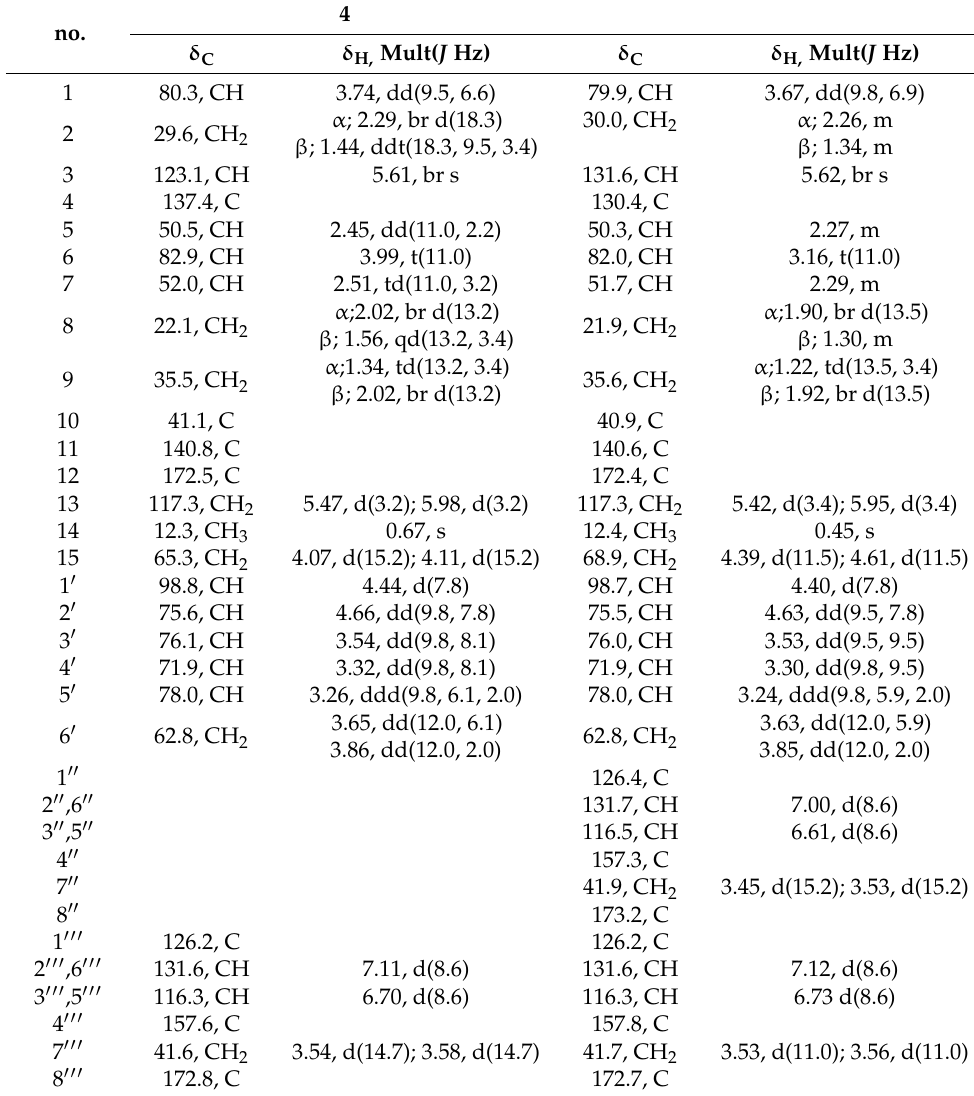
Table 1. The 1 H (500 MHz) and 13 C NMR (125 MHz) data for 4 and 5 in CD 3 OD ( δ in ppm, J values in